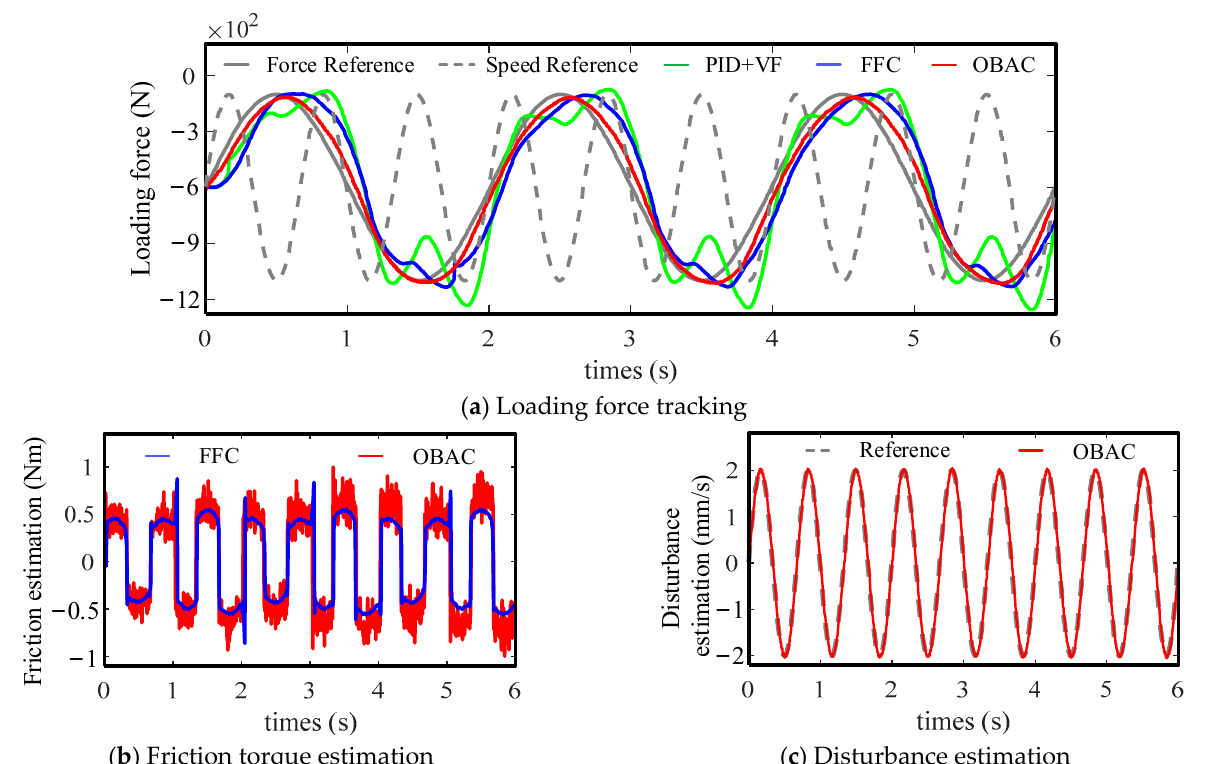
Figure 8. Dynamic loading experiment results (different frequency operation for tested EMA). Table 4. Performance indexes for the dynamic loading experiment (out-of-phase operation for tested EMA).